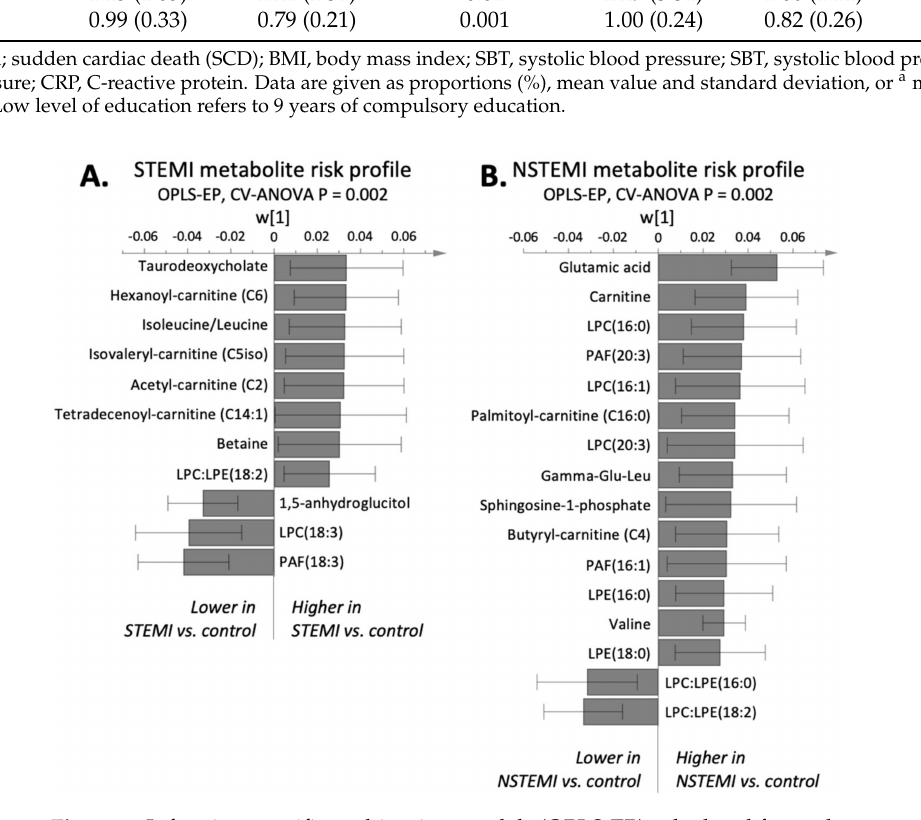
Figure 1. Infarction-specific multivariate models (OPLS-EP) calculated from plasma metabolomics. Annotated parameters that were significantly ( p < 0.05) different between cases and their matched controls are included. ( A ) STEMI metabolite risk profile. ( B ) NSTEMI metabolite risk profile. The multivariate confidence intervals indicate significance on a 95% based on